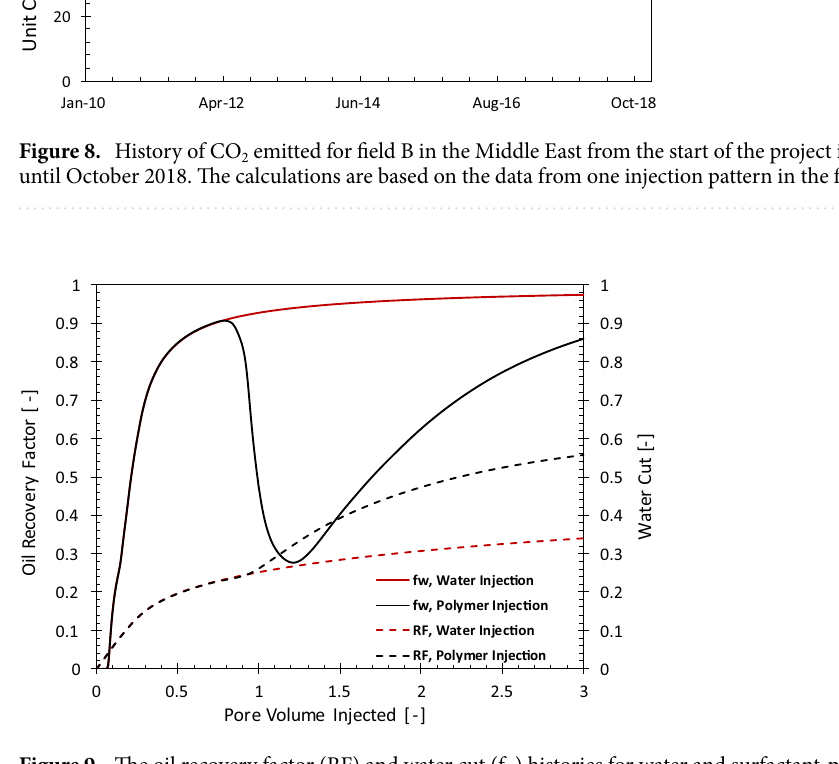
the reservoir pressure remains nearly constant due to the strength of the aquifer. This means that no additional ˙ Ex pr , pump = 0 . Figure 7 plots the ratios of the CO water injection is required to displace the oil, i.e., water 2 emitted and exergy invested between polymer injection and natural aquifer drive.. In this case, polymer EOR has larger exergy ˙ Ex pr , pump > 0 . investment, because it requires pumping of significant volumes of polymer-containing water, i.e., polymer However, injection of polymer, leads to reduction in exergy investment in lift pumps and excessive water treat- ment. This combined with the fact that polymer does not produce CO 2 in the reservoir (no oxidation) eventually results in smaller CO 2 footprint for the PI case compared to the aquifer-drive production scheme. Figure 8 uses the oil recovery results of a polymer injection pattern in another field in the Middle East. Water injection was the main recovery mechanism for this reservoir until the water cut reached the value of 95% in January 2010. At this point, the injection of polymer started, which resulted in a water-cut reversal, similar to Fig. 2. The dashed line and the circles in Fig. 8 compare the unit CO 2 emission for water injection (in case it continued) and polymer injection. The polymer-injection project has a significantly smaller carbon footprint. Figure 9 shows the impact of injecting surfactant/polymer on oil recovery and water cut in comparison with the water injection. The characteristics of the oil recovery are similar to that of the polymer flooding, i.e., injection of surfactant/polymer leads to the formation of an oil bank. As a result, the water cut first decreases (more significantly than polymer injection) and after the breakthrough of the chemicals, the water cut starts to increase. The history of the exergy recovery factor for the surfactant-polymer injection, shown in Fig. 10, is similar to that of the polymer injection. For the surfactant-flooding, the first deviation from water flooding (dashed line) occurs when soft water is injected to remove the divalent ions. With the injection of the chemicals, the rate exergy recovery factor significantly decreases, which is because of the large exergy invested in the manu- facturing of the chemicals (surfactant and polymer) compared to the small exergy gain before arrival of the oil bank in the producers. To maintain stable displacement larger viscosity (or polymer concentration) is required